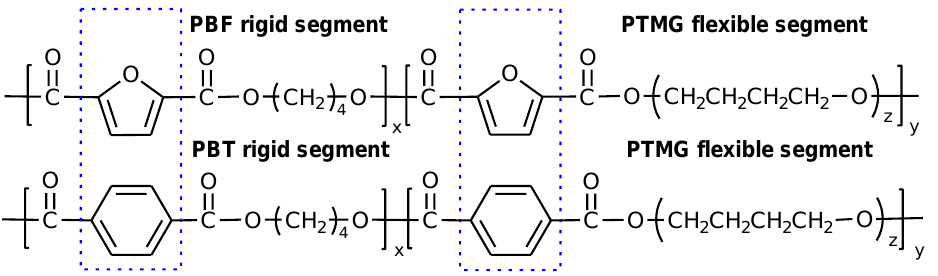
Figure 1. The chemical structures of two compared copolyesters: PBF-b-PTMG vs. PBT-b-PTMG.